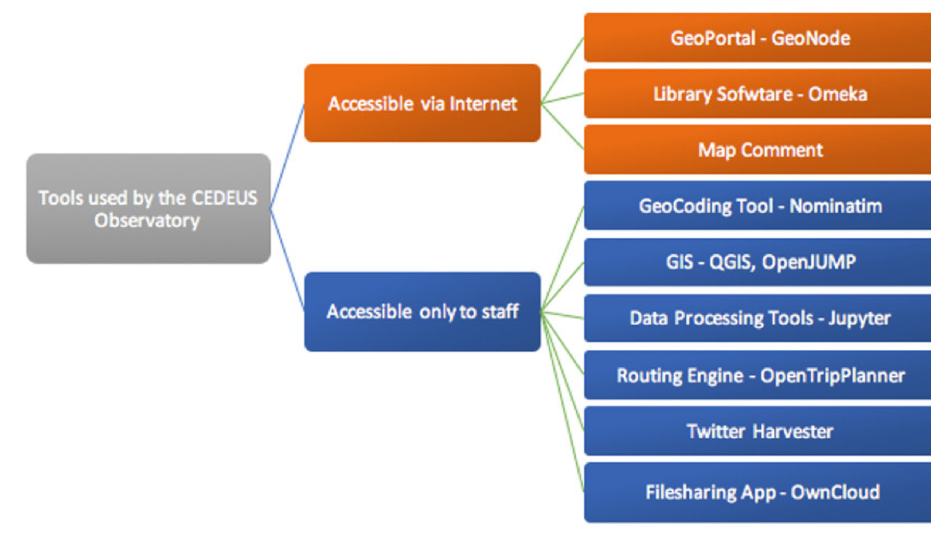
Figure 3. Important aspects that need to be considered for the creation of a geographic data repository for